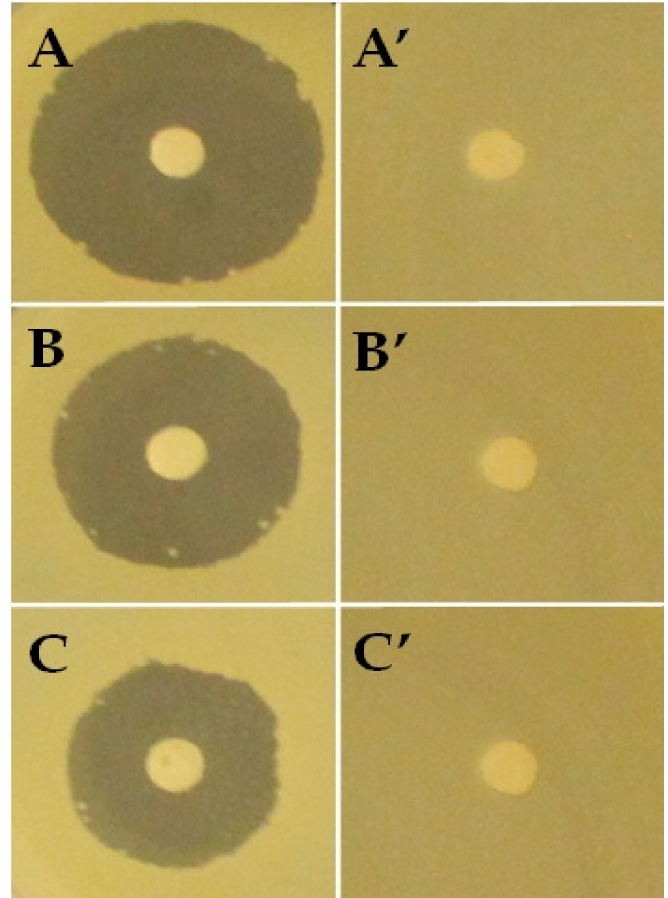
Figure 10. Antibacterial activity. ( A ) PEVAL/PDVAL/ β -TCP70; ( B ) PEVAL/PDVAL/ β -TCP50; ( C ) PEVAL/PDVAL scaffolds with antibiotic and ( A’ ); ( B’ , C’ ) without